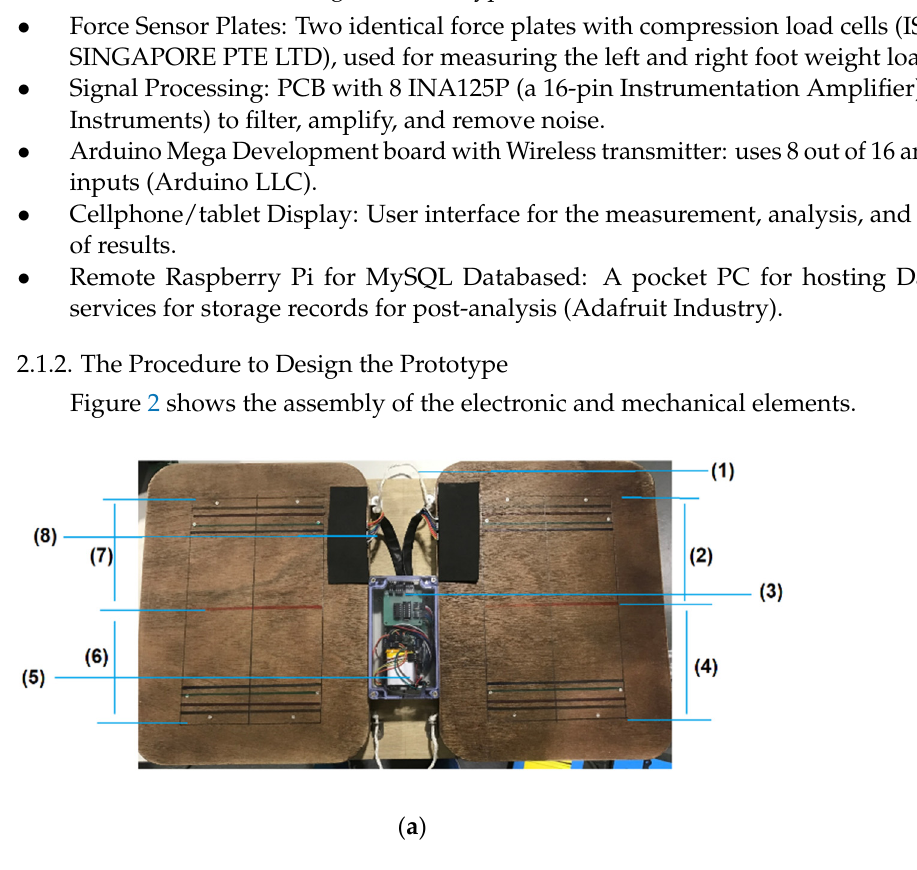
Figure 1. The design of the ENP: ( a ) an overview of the developed system, the segregation of eight different regions of the foot arches, and the placement of the sensory cells within the force sensor plates for signal processing, Wi-Fi transmission, iCloud databasing, and displaying and transmitting results; ( b ) the schematics of the electronics with one load cell connection exemplified.